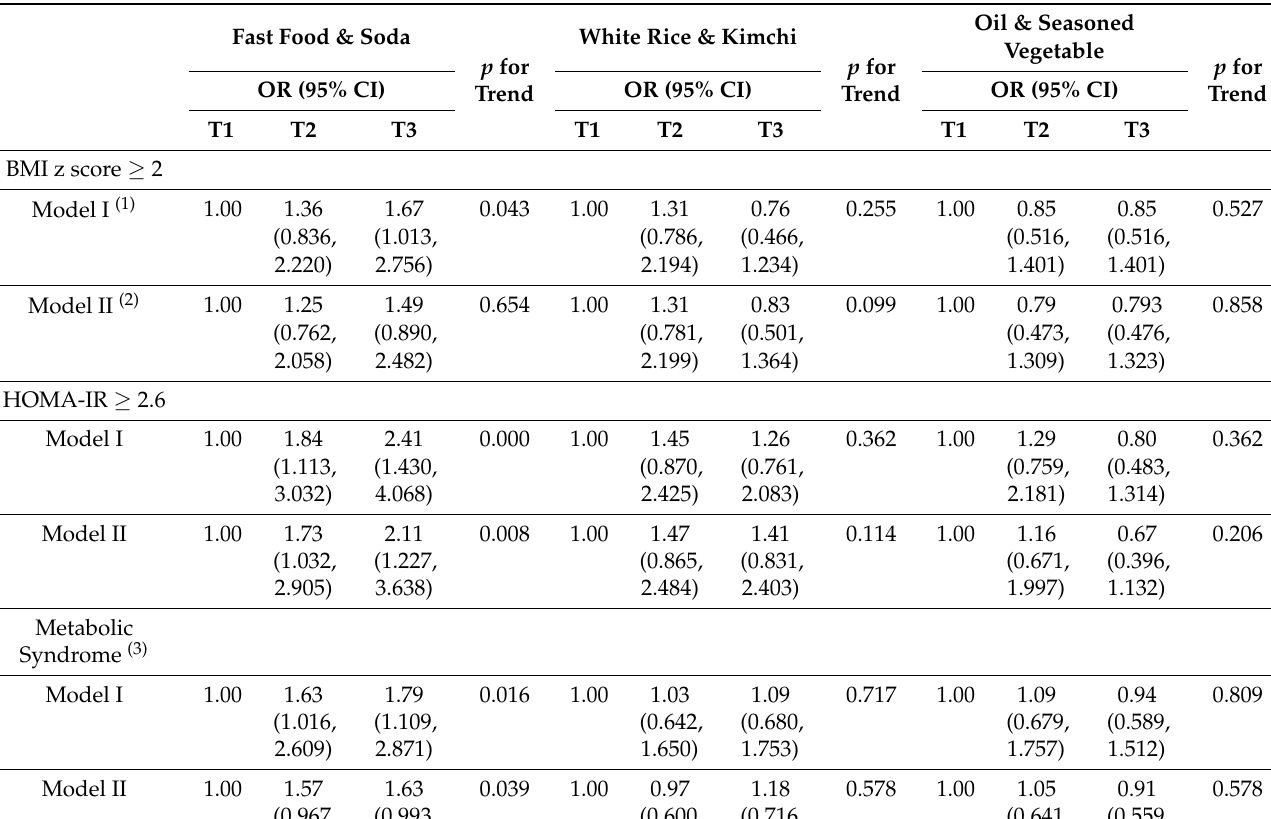
Table 5. Associations (OR and 95% CI) between tertiles of dietary patterns and obesity, insulin resistance, and metabolic syndrome in Korean children and